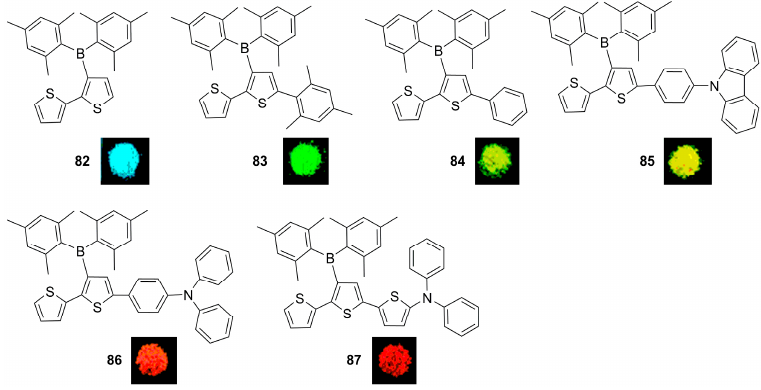
Figure 14. π -Conjugated materials 82 – 87 with Mes 2 B pendants.